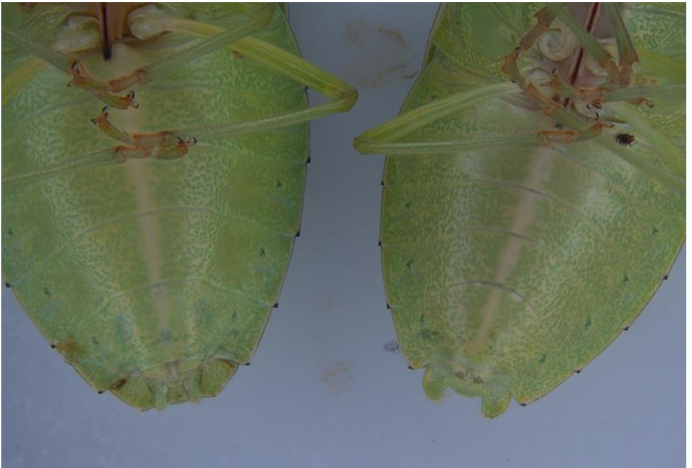
Figure 1. Nezara viridula female ( left ) and male ( right ). Notice the claspers on the terminal abdominal segment (right) (Photo by Katherine Parys